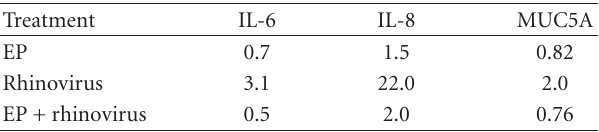
Table 5: E ff ects of EP on cytokines/mucin in 3-D tissues (ratio,